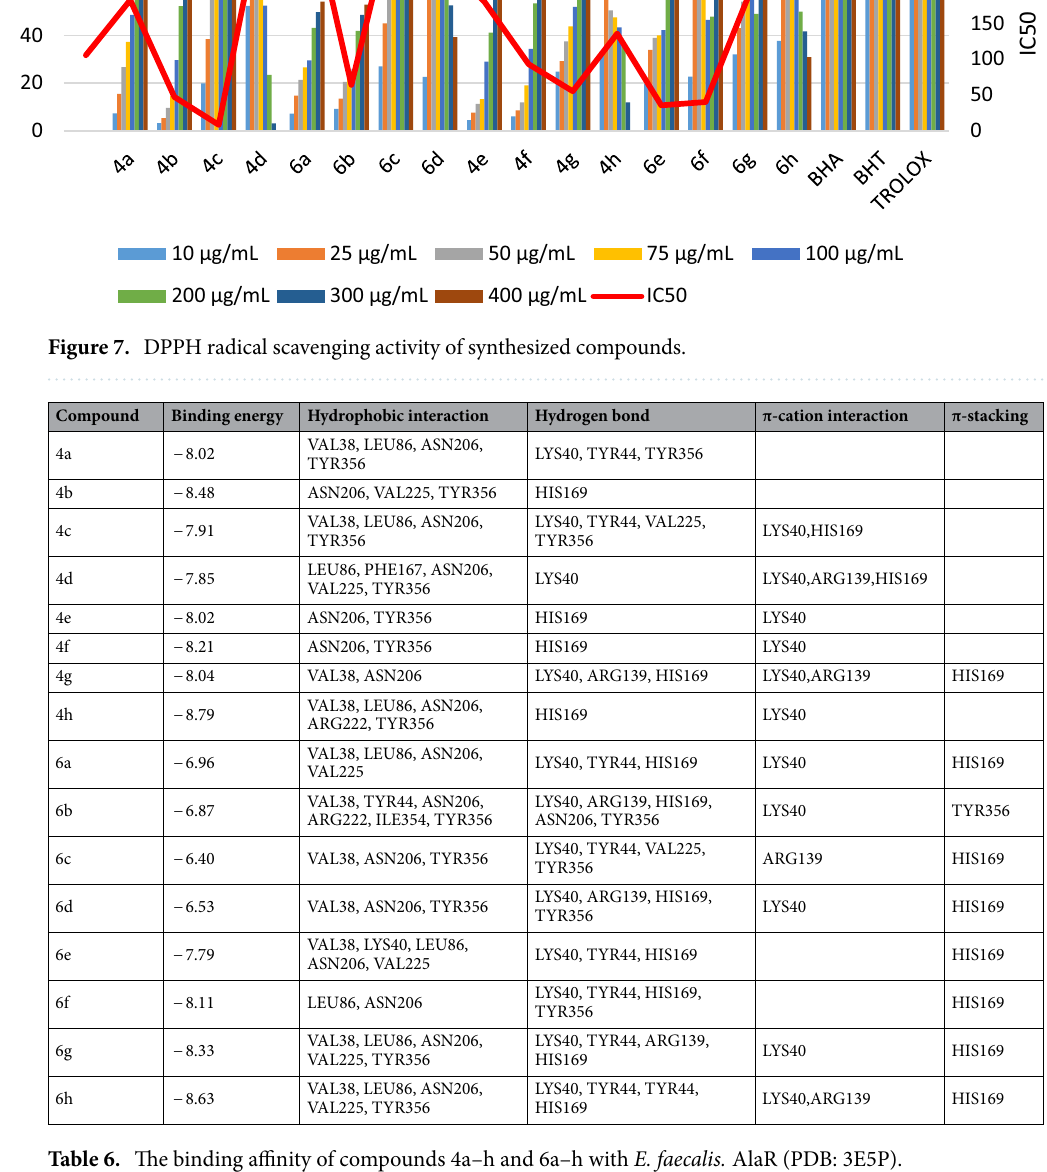
Table 6. The binding affinity of compounds 4a–h and 6a–h with E. faecalis. AlaR (PDB: 3E5P).